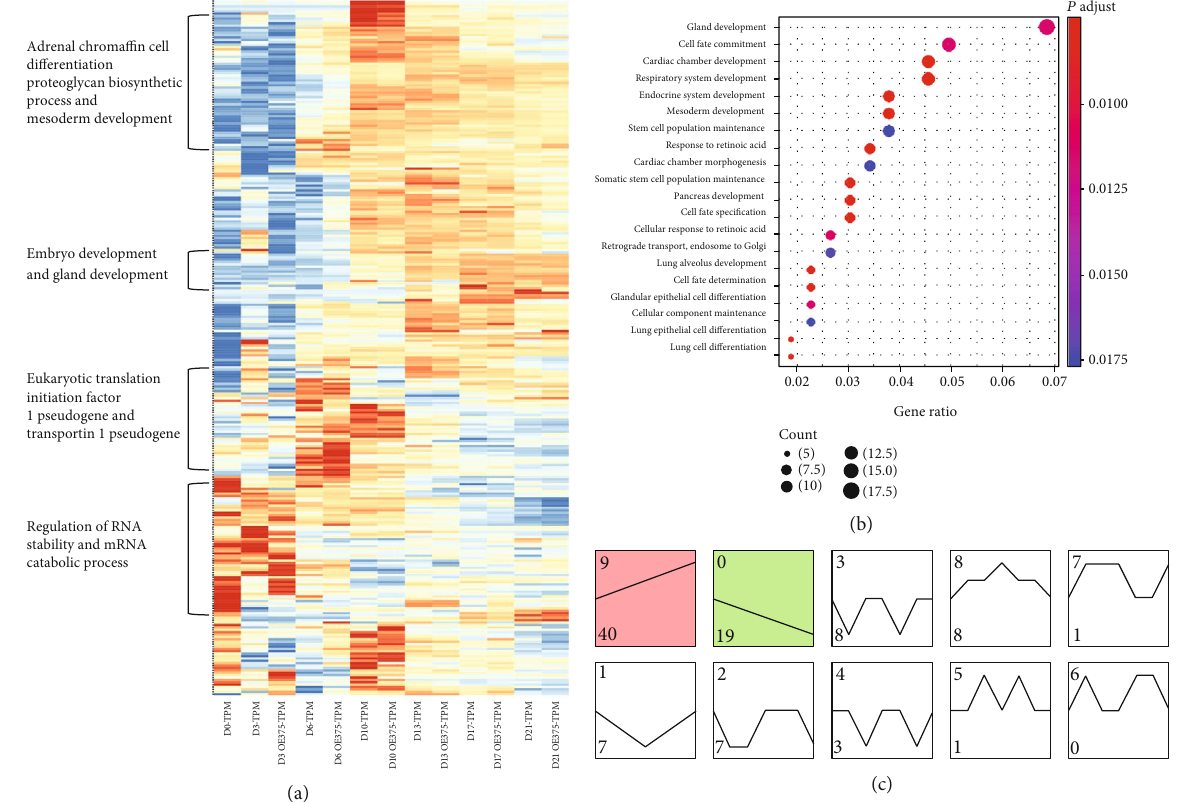
Figure 4: Overall description of 272 possible miR-375 target genes for the four di ff erentiation stages in control vs. OE and control vs. IE. (a) Heatmap showing the expression levels of 272 possible miR-375 target genes in the four di ff erentiation stages in the OE, IE, and control groups. Hierarchical clustering of gene expression patterns was performed, and its expression level was standardized to TPM (transcripts per kilobase of exon model per million mapped reads). (b) Dot plot showing the KEGG enrichment pathways of 272 possible target genes. The abscissa represents the gene enrichment ratio, the bubble size represents the number of enriched genes in this pathway, and the color represents the q value (adjusted P value). (c) Trend analysis of target gene expression (10 trends) by STEM (Short Time-series Expression Miner). Colored blocks: signi fi cantly enriched trend ( P < 0 : 05